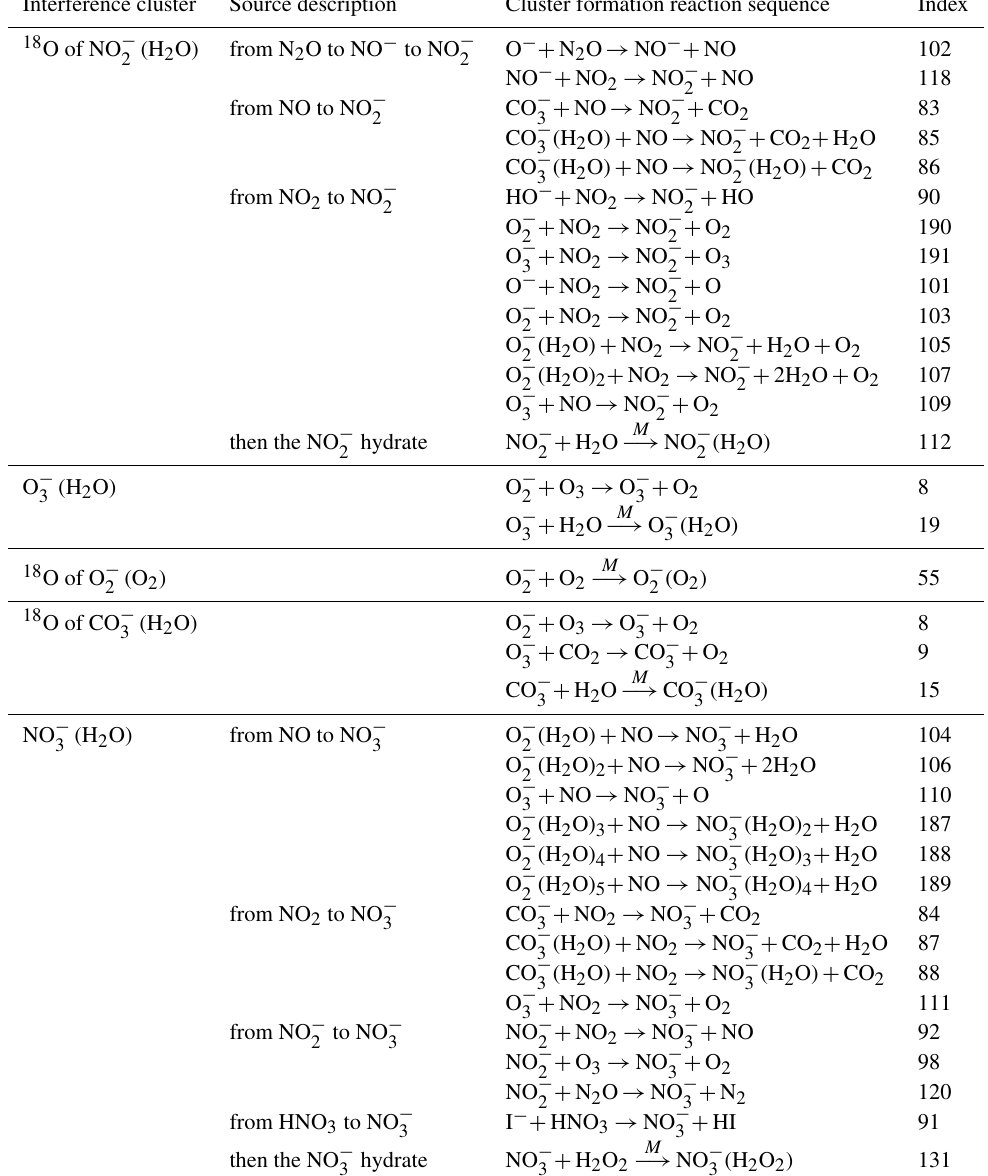
( H 2 O ) ] for O − ( CH 3 OOH ) 3 2